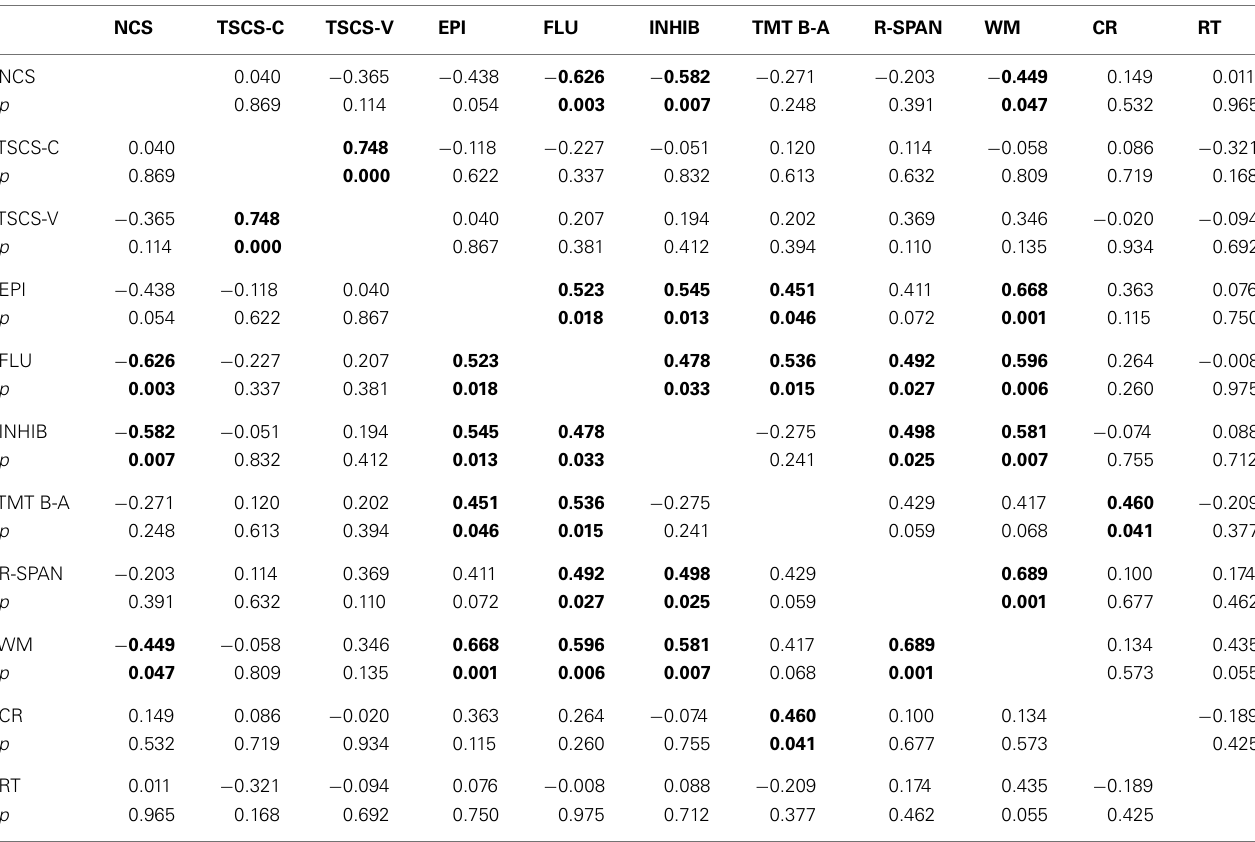
Table 1 | Correlations between self-concept, episodic and neuropsychological